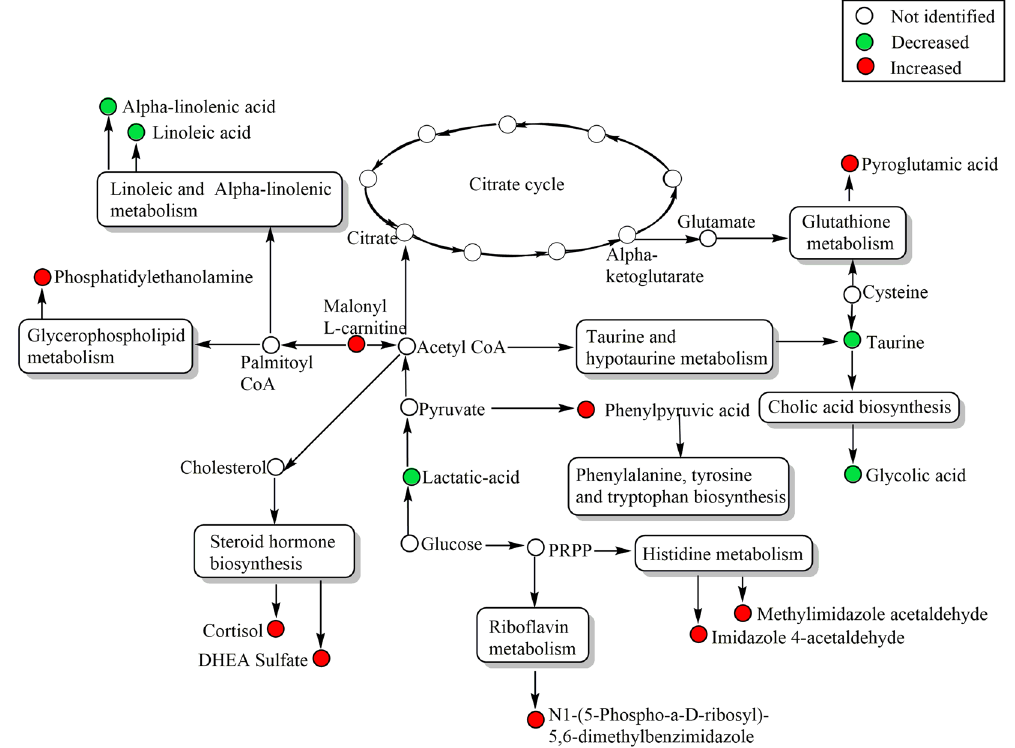
Figure 3. The integrative ruminal metabolic pathway changes on the steers with the greatest average daily gain compare to the least ADG with similar average dry matter intake according to Bos taurus KEGG pathway database. UPLC-qTOF 90 metabolites identified to differ between ADG by t-test ( P <